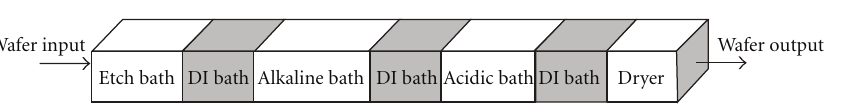
Figure 2: Chemical process steps of an inline roller type